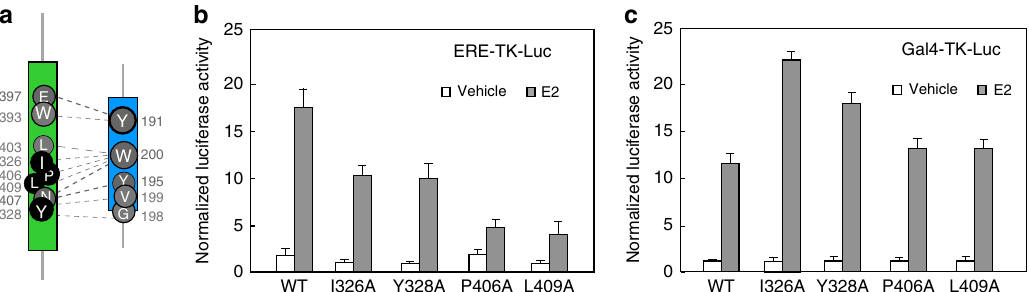
Fig. 4 Transcriptional regulation of mutations at interfacial LBD residues. a Sites of LBD mutation (I326, Y328, P406, and L409), highlighted in black circles. b – c Transient transfection reporter activity of the hER α and the Gal4-DBD/hER α -LBD fusion protein, using an ERE-TK-Luc ( b ) or a Gal4-TK-Luc reporter construct ( c ), respectively. Triplicates were carried out and standard deviations were indicated